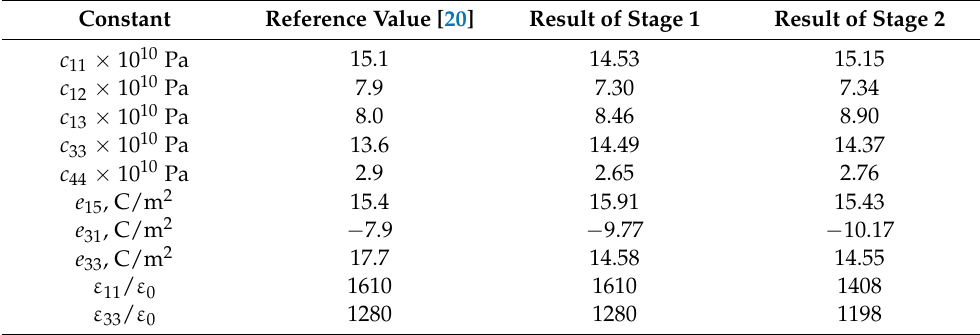
Table 2. The reference and refined material constants of the resonator made of piezoelectric ceramics barium lead zirconate titanate (BPZT).